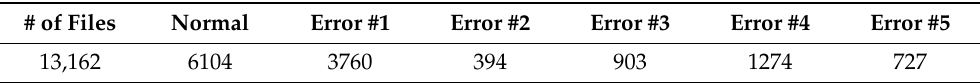
Table 2. Number of datasets for anomaly